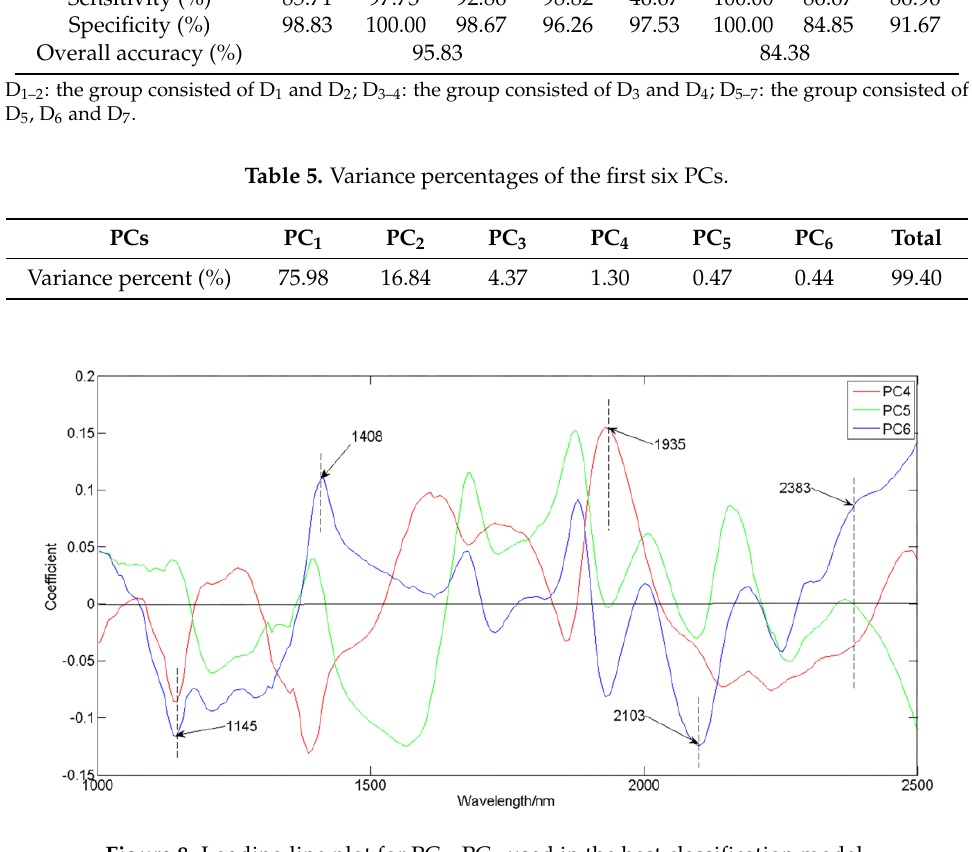
Figure 8. Loading line plot for PC 4 –PC 6 used in the best classification model.